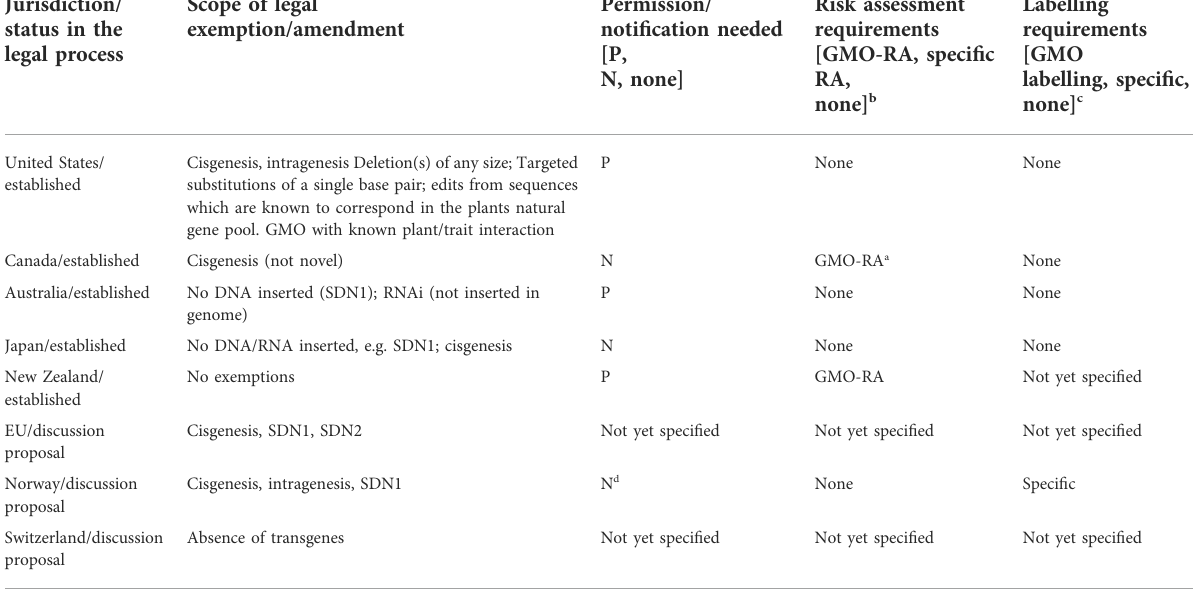
TABLE 5 Scope of legal exemptions or amendment for genome-edited plants established or proposed in the jurisdictions considered. Jurisdiction/ status in